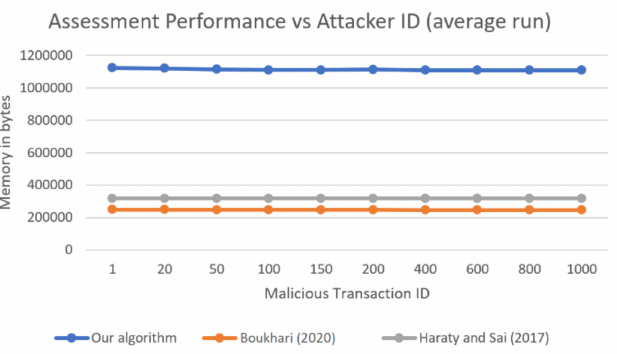
Figure 6. Comparison of the total memory used in the average of 10 runs by three algorithms as a function of the malicious transaction